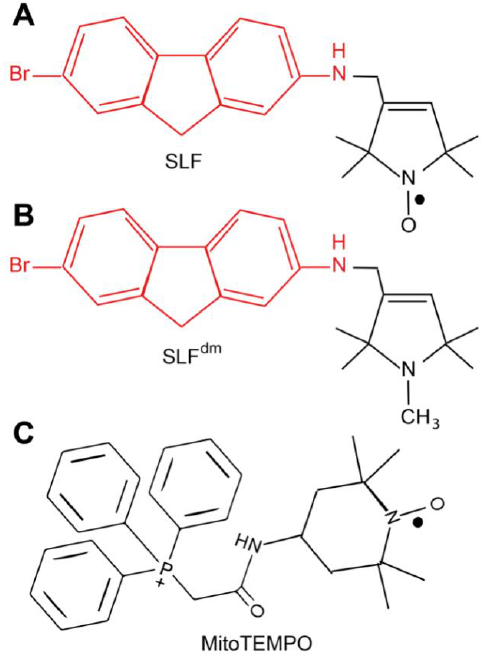
Figure 1. ( A ) The chemical structure of the spin-labeled fluorene (SLF). The amyloid-targeting domain is shown in red and the nitroxide spin label moiety is shown in black. The diamagnetic form of SLF (SLF dm ) that lacks the nitroxyl antioxidant capacity is shown in ( B ). ( C ) The structure of the antioxidant MitoTEMPO.